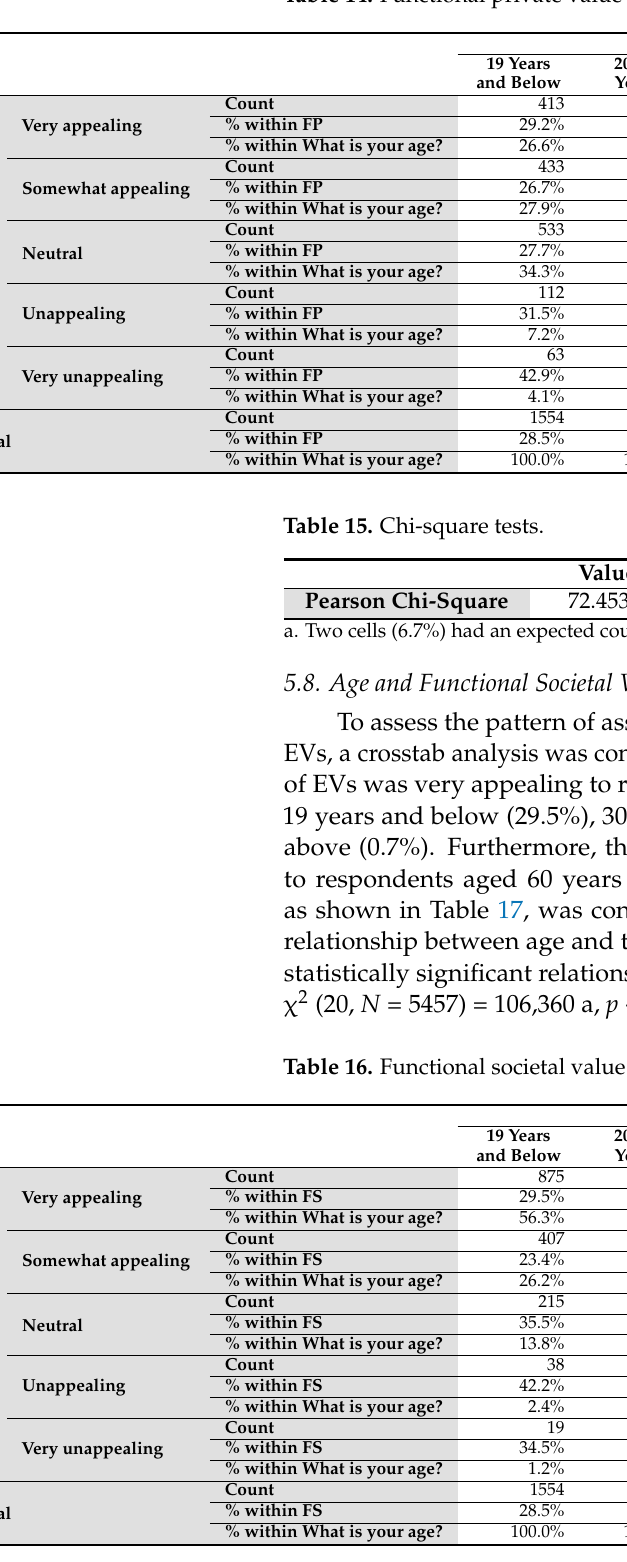
Table 14. Functional private value of EVs and respondents’ age cross-tabulation.